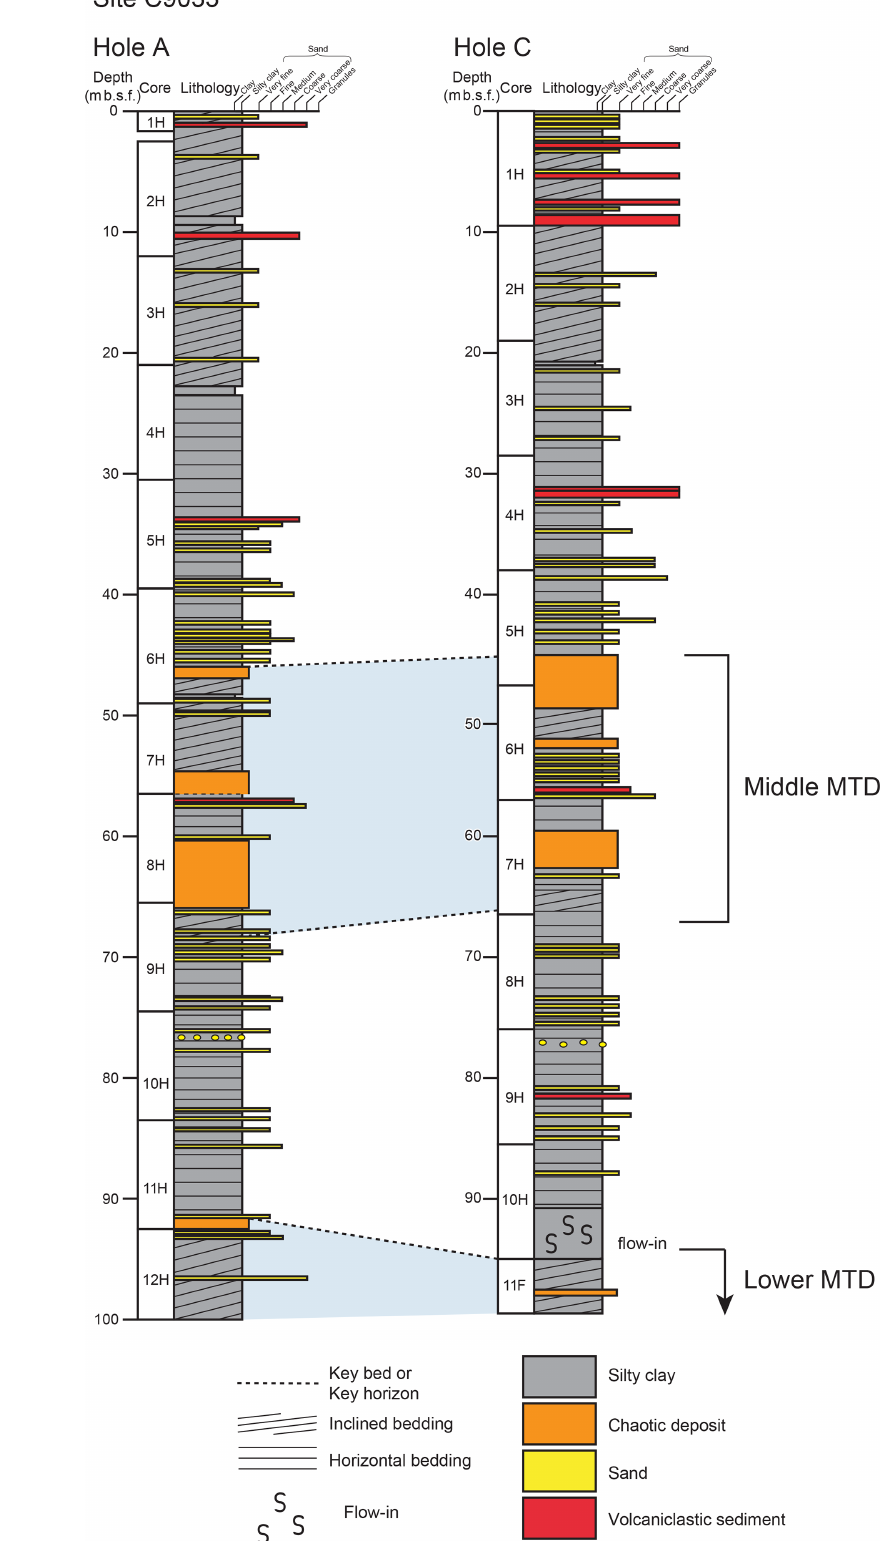
Figure 5. Lithologic column figure of Holes A and C at Site C9033. The combination of chaotic deposits and inclined beds is interpreted as mass transport deposits (MTDs). Two MTD units observed in the middle part of the core comprise “Middle MTD” in the seismic profile, whereas the MTD unit in the bottom corresponds to the top of “Lower MTD”. Inclined bedding in the top 20m may be another MTD